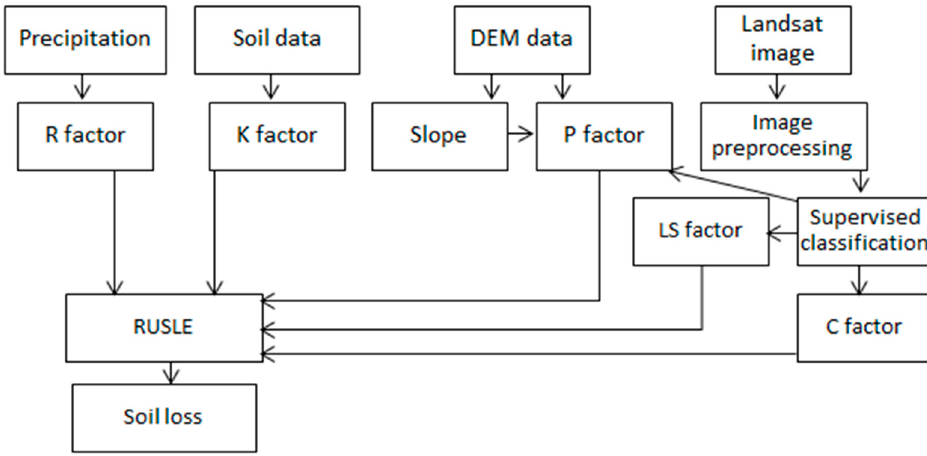
Figure 3. Methodology flow chart showing revised universal soil loss equation (RUSLE) model for soil loss estimation [88].